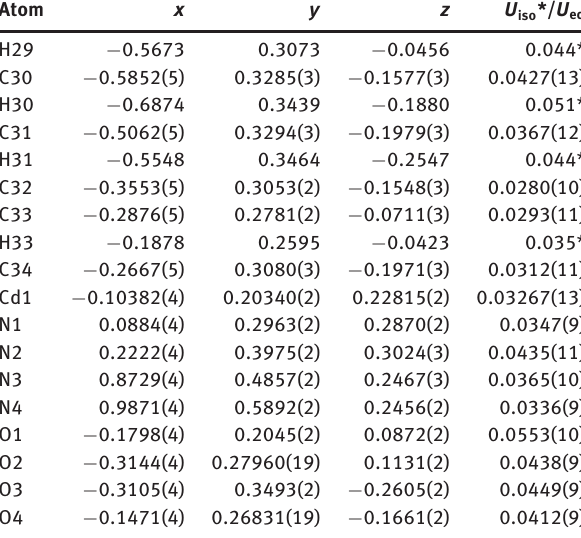
Table 2: Fractional atomic coordinates and isotropic or equivalent isotropic displacement parameters (Å 2